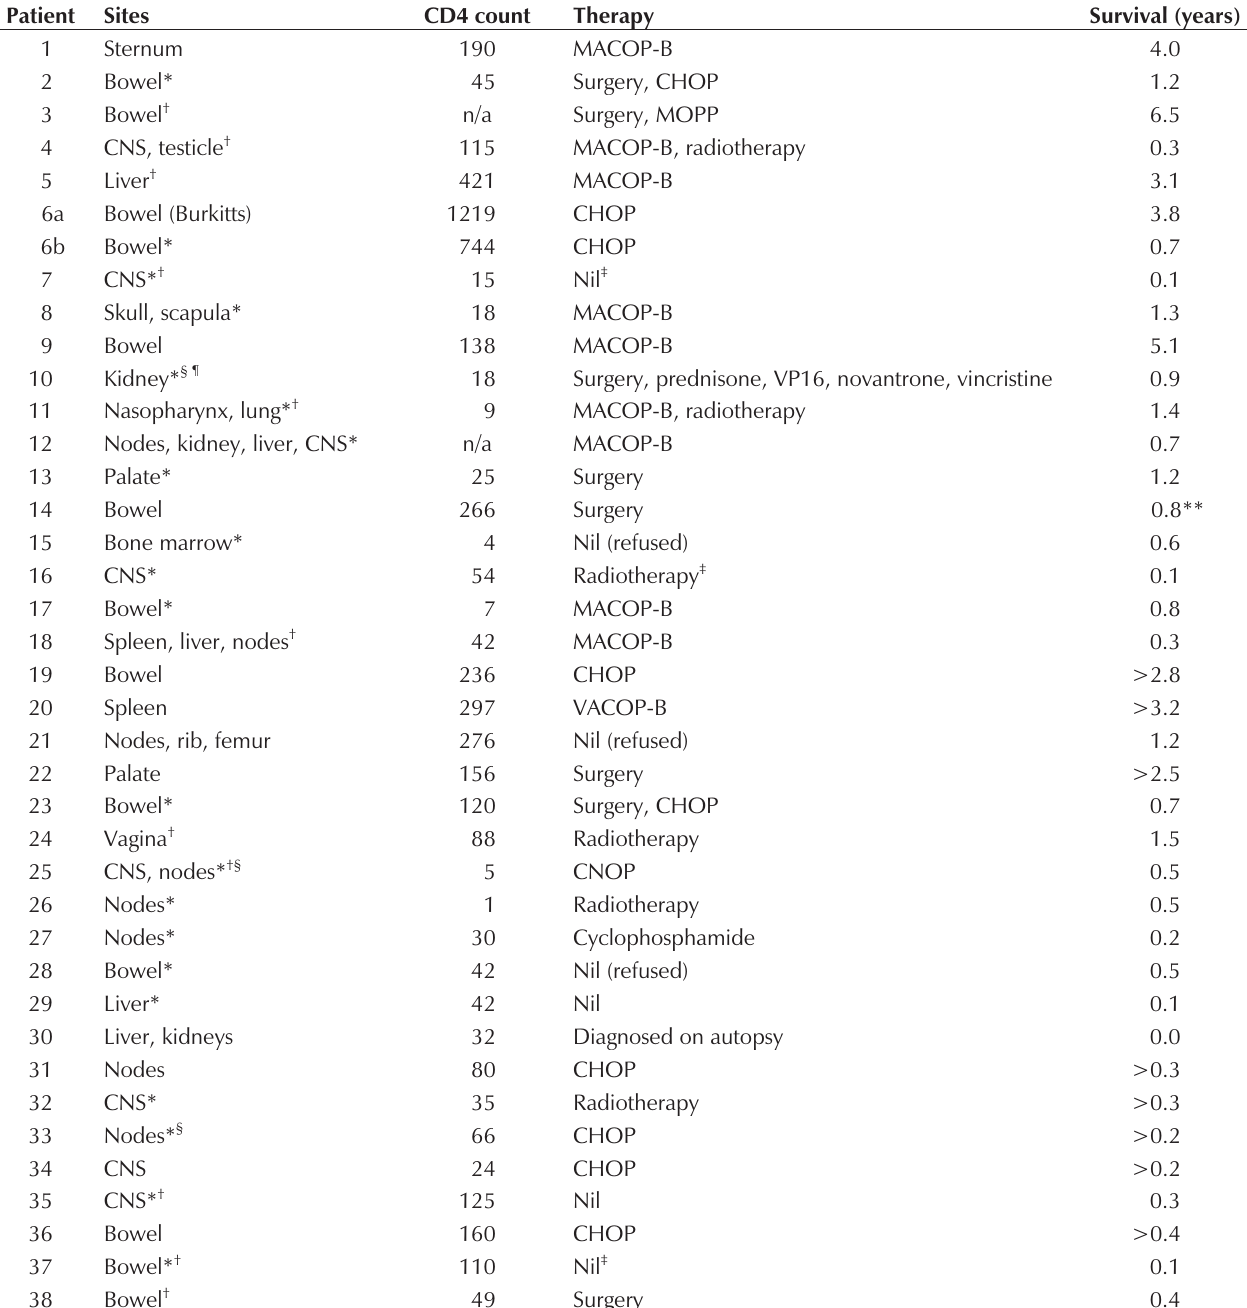
The Southern Alberta HIV Clinic cohort of HIV-associated non-Hodgkin’s